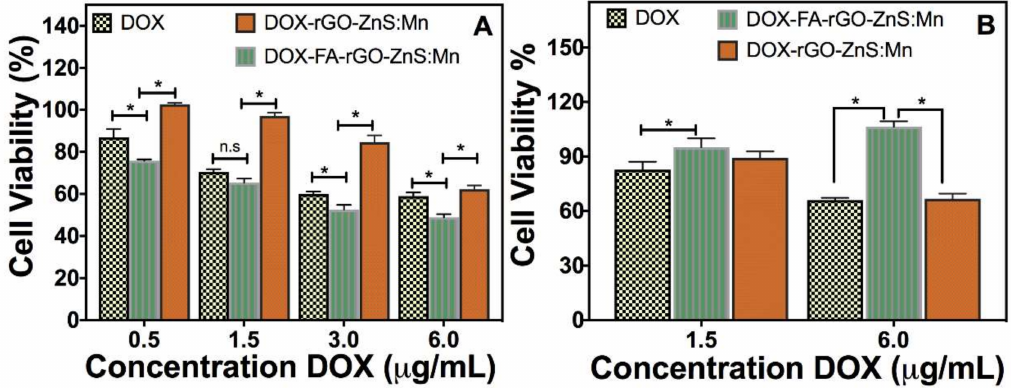
Figure 6. Chemotherapeutic effect of DOX-FA-rGO/ZnS:Mn and DOX-rGO/ZnS:Mn in ( A ) MDA-MB-231 cancer cells and ( B ) NIH-3T3 cells after 24 h of incubation. p -values are shown as follows: ns, non-significant and * p < 0.05 is considered as